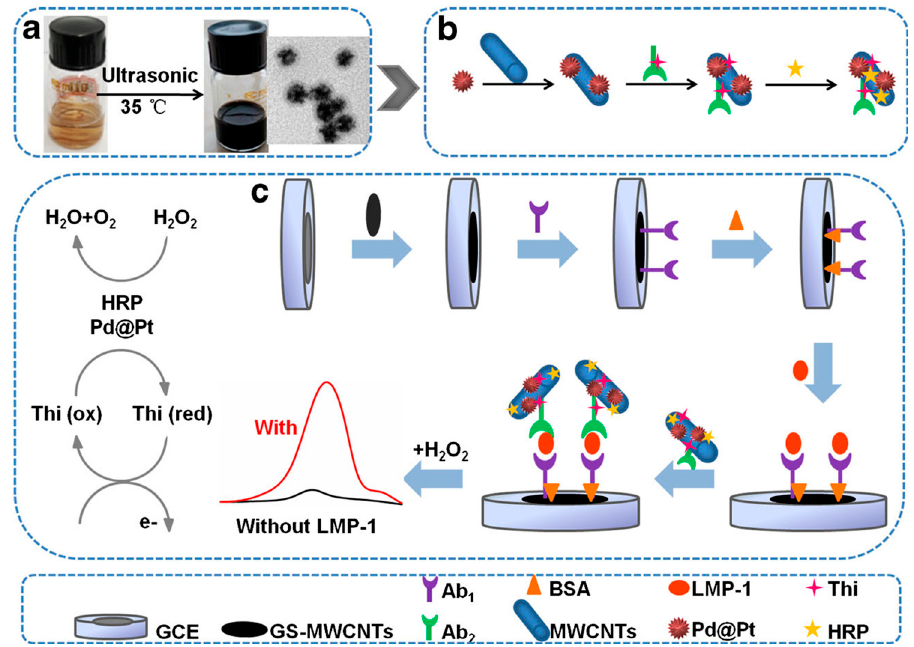
Figure 6. ( a ) Photographs of solutions before and after the reaction; ( b ) preparation of Ab 2 /Thi/HRP/Pd@Pt-MWCNTs; ( c ) fabrication procedure for LMP-1 immunosensor and DPV detection. Reprinted from [28] with permission.